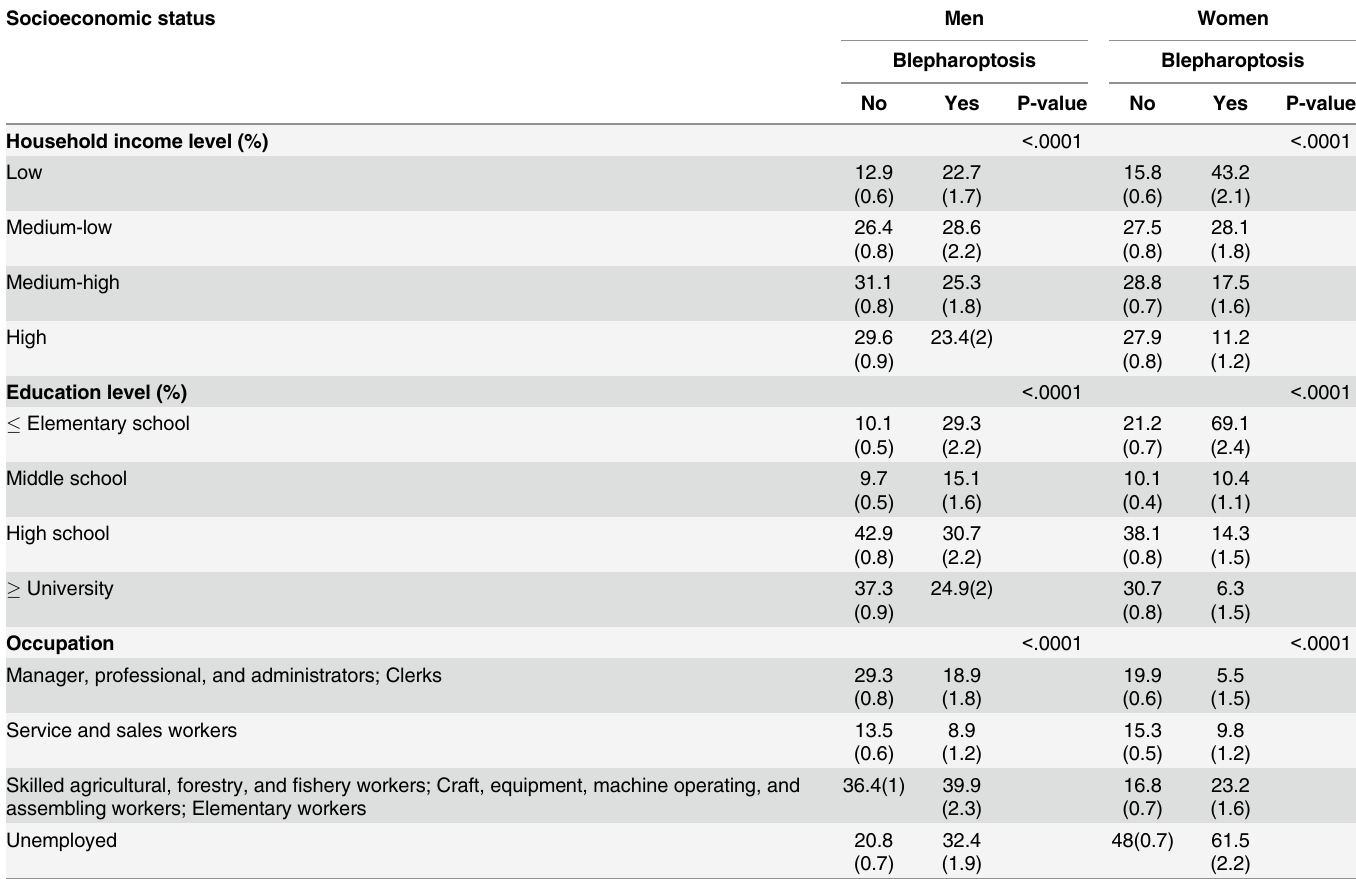
Table 2. Distribution of the prevalence of blepharoptosis according to socioeconomic status and occupation among men and